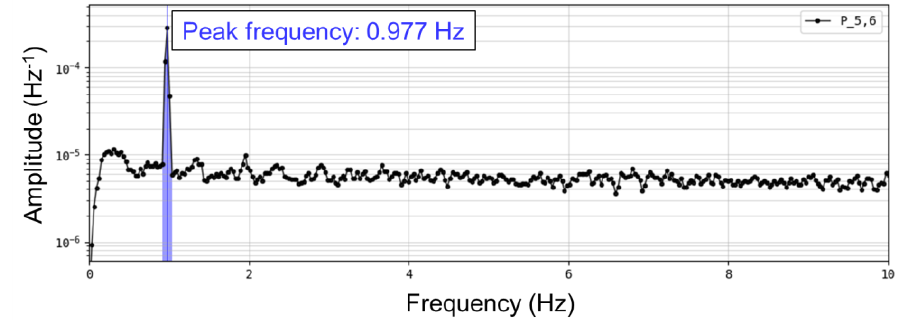
Figure 2. Example of a computed cross-power spectral density of detectors 5 and 6, for an experiment with oscillation at ±1.5 mm/1 Hz. The peak power 𝑃